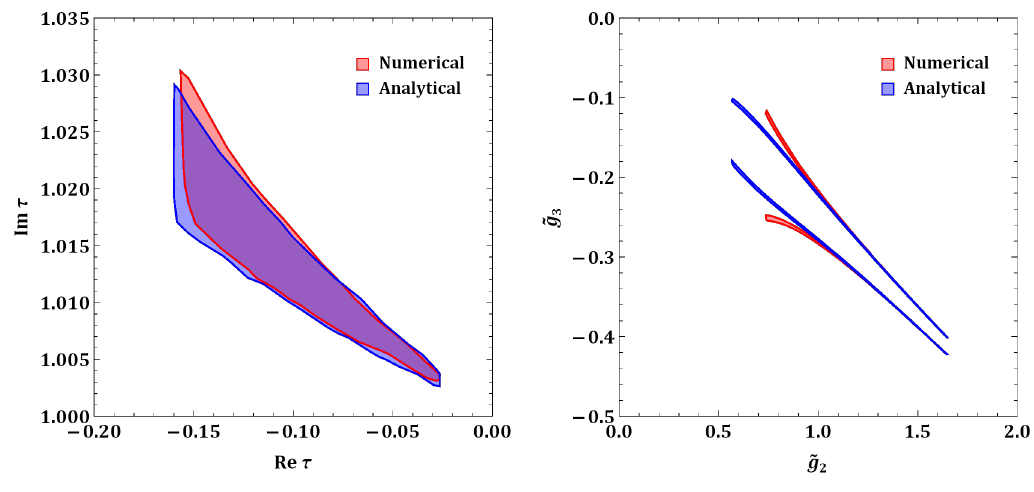
g , g } obtained by inputting the approxi- e e 2 3